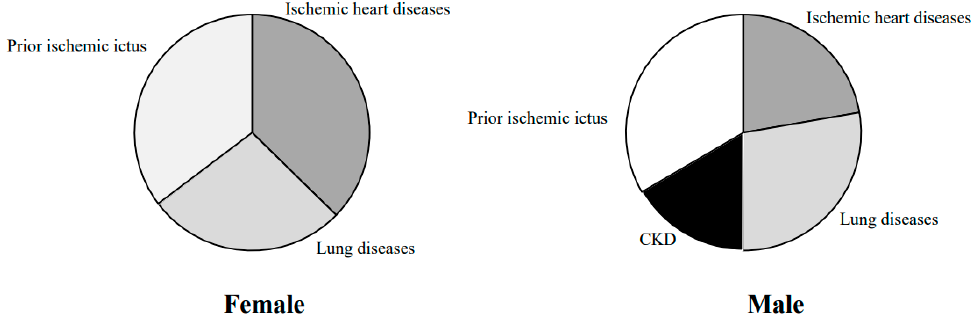
Figure 1. Comorbidity by gender differences.